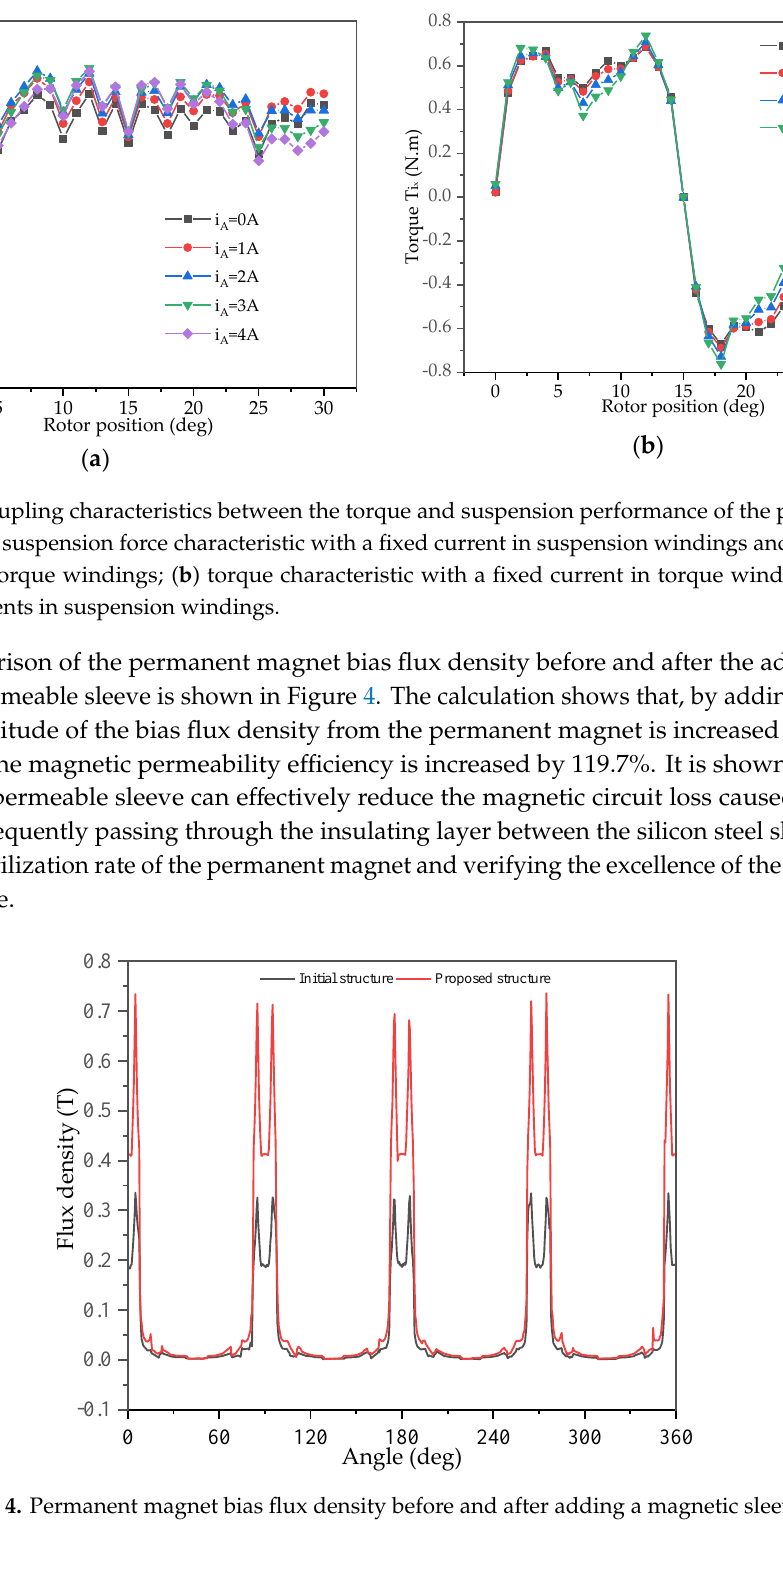
Figure 4. Permanent magnet bias flux density before and after adding a magnetic sleeve.